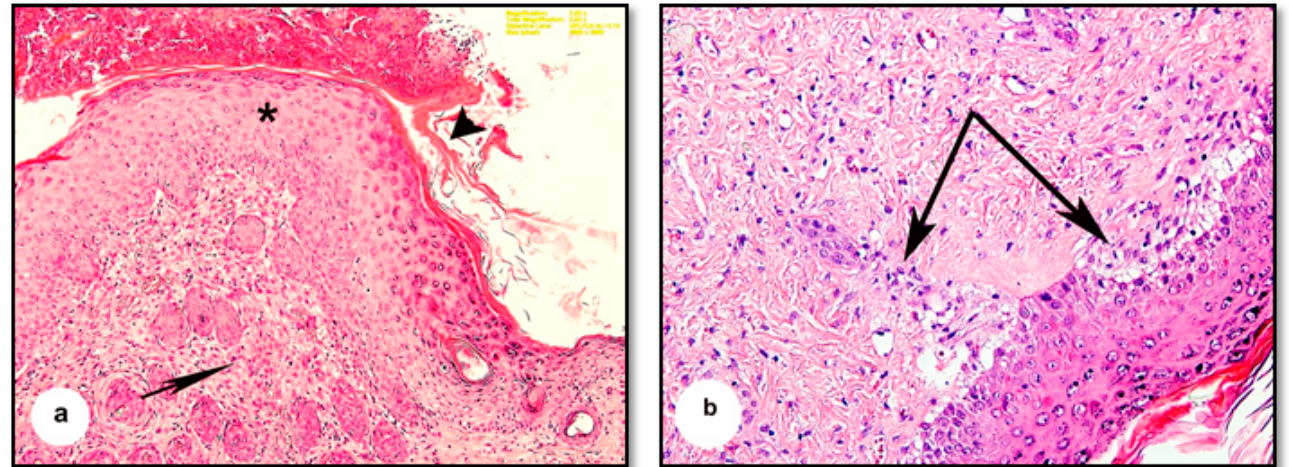
Figure 6. Photomicrographs of sections of burnt wounds in the mice skin treated with 1% SSD. ( a ) Showing highly thickened epidermal layer (*), some distortion of the horny layer (arrowhead.), moderate granulation of the dermis (arrow). ( b ) Showing slight cellular infiltration (arrows), (H & E, scale bar: a = 100 µ m, b: Magnification: 2.52 ×).